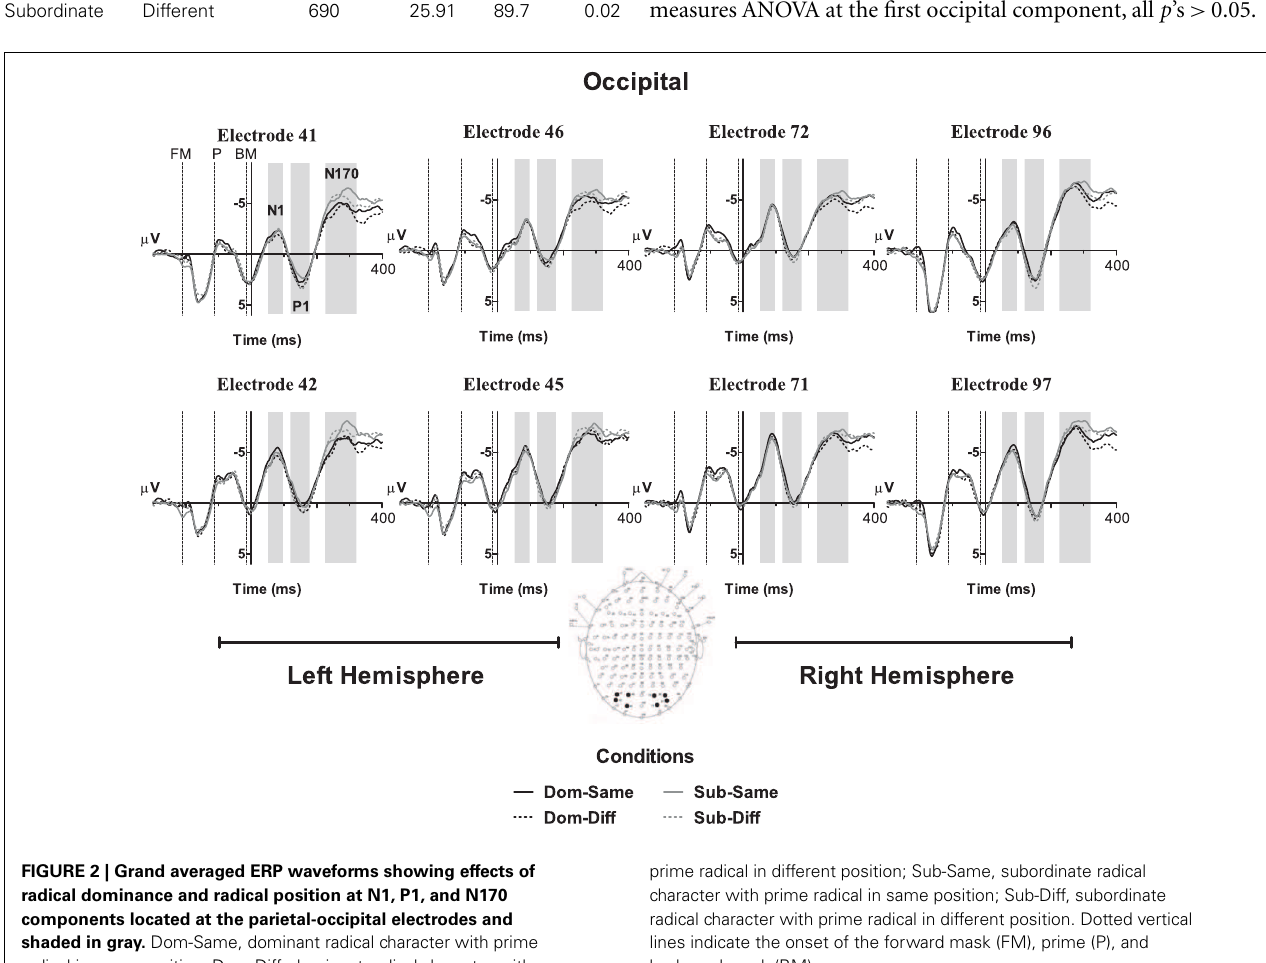
FIGURE 2 | Grand averaged ERP waveforms showing effects of radical dominance and radical position at N1, P1, and N170 components located at the parietal-occipital electrodes and shaded in gray. Dom-Same, dominant radical character with prime radical in same position; Dom-Diff, dominant radical character with